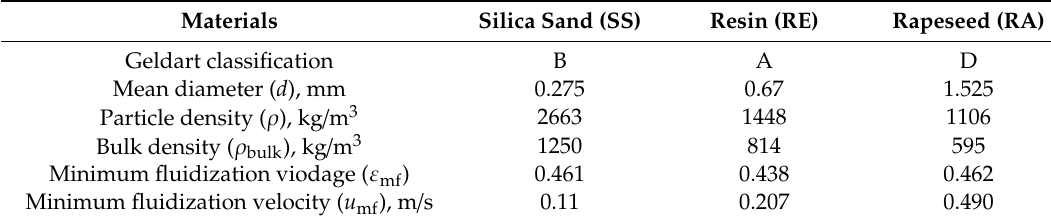
Table 1. Physical property of particles.